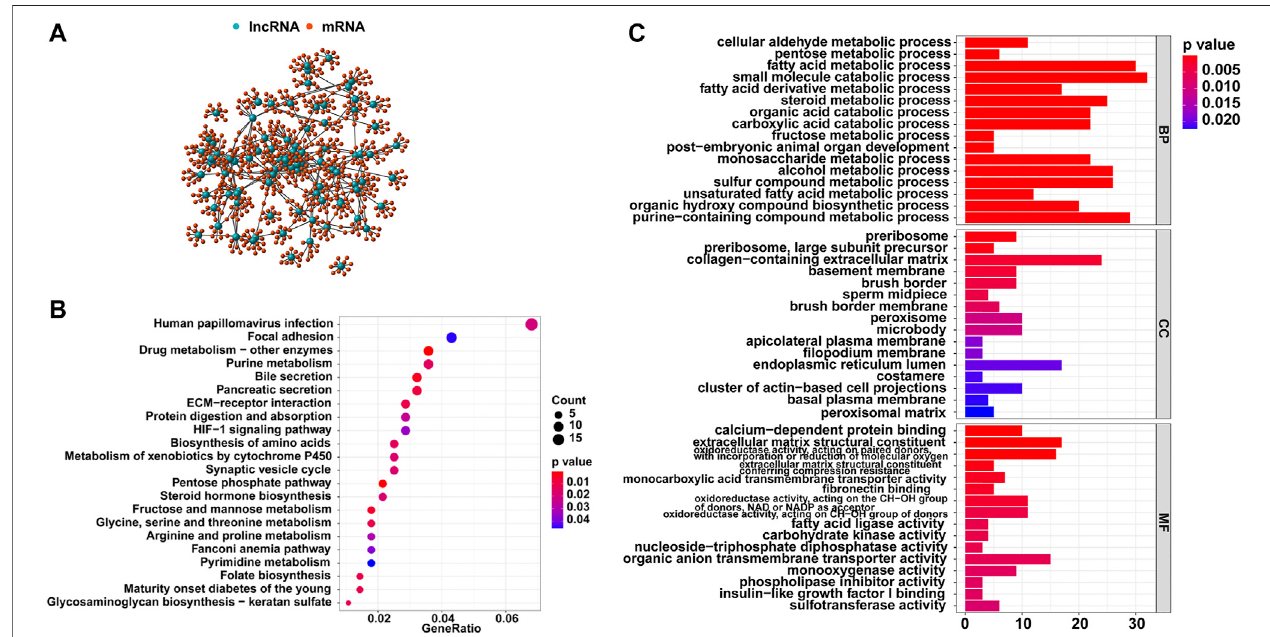
FIGURE 2 | Functional analysis of the GI-related lncRNAs in HCC. (A) Co-expression network of GI-related lncRNAs and top 10 relevant mRNAs. (B) KEGG enrichment analysis for the co-expressed genes. (C) GO functional analysis for the co-expressed genes.